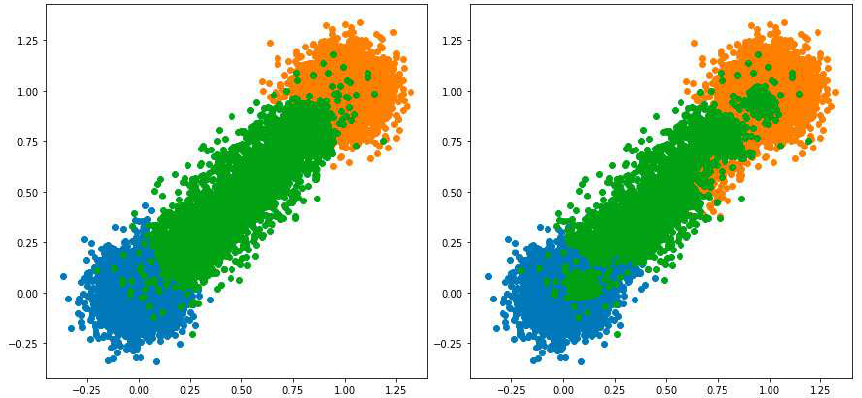
Figure 7. Example of instances from the DS 3 , classified by HPFuzzNDA (the left graph) and PFuzzND (the right graph) algorithms.